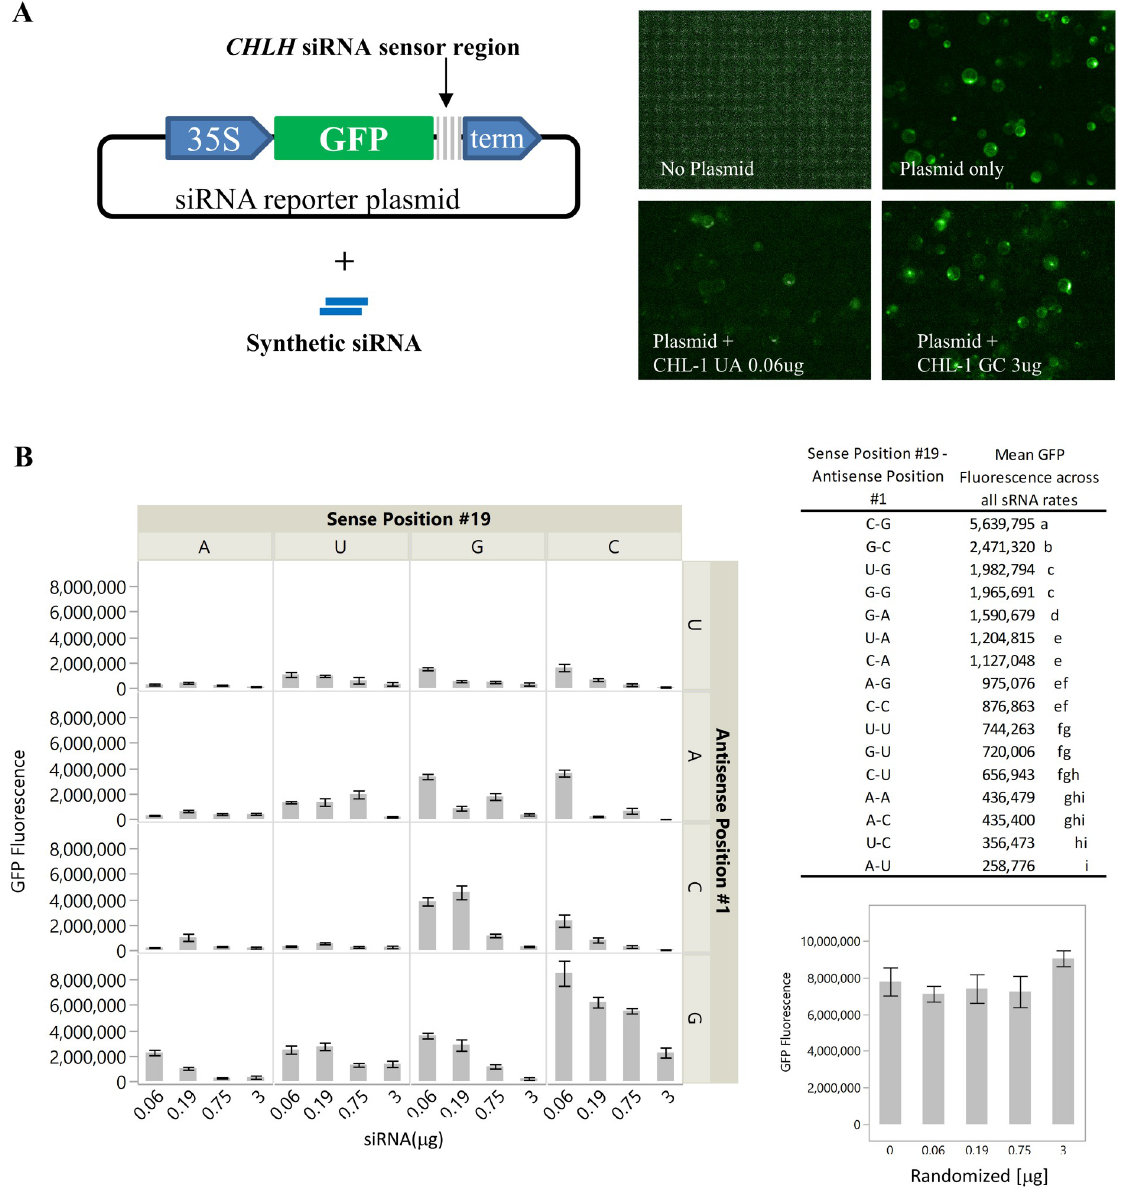
Fig 4. Silencing of a GFP : CHLH -fragment fusion in protoplasts was used to measure the efficiency of silencing for sixteen CHLH siRNA variants. A, Diagram of the siRNA reporter plasmid containing the GFP : CHLH fragment:3’ UTR cassette for gene suppression in protoplasts, the synthetic siRNAs, and the representative protoplast images captured by Oppereta imager of no plasmid, plasmid only, plasmid + CHL-1 UA, and plasmid + CHL-1 GC. B, siRNAs as described in the legend to Fig 3 were transfected together with the GFP : CHLH -fragment fusion, and GFP fluorescence was quantified at 525 nm with 488 nm excitation. Means not followed by the same letter indicate statistical significance ( α = 0.05).